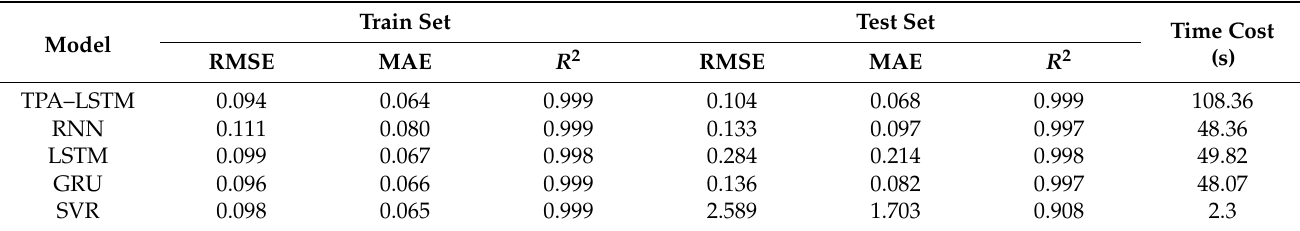
Table 8. Criteria of different prediction